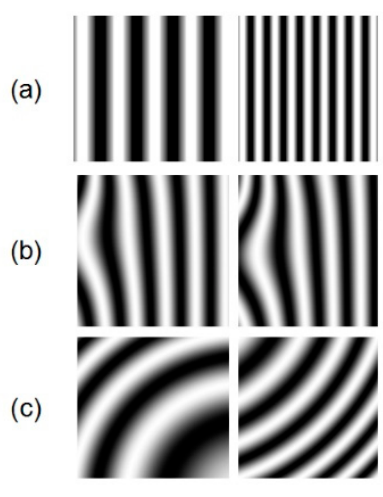
Figure 5. Simulated fringe patterns. The fringe projection technique is often used to determine the 3D-profile of an object. When the fringe pattern is projected on a measured free surface, its phase is modulated by the height distribution of the object. We used the fringe pattern captured from the fringe projection experiment to verify the ability of the neural network to extract the phase map. Figure 6a,b show schematic layout and physical diagram of the experiment, respectively.